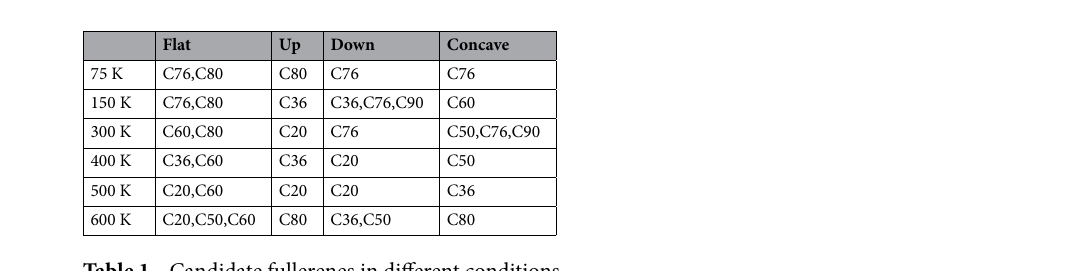
Table 1. Candidate fullerenes in different